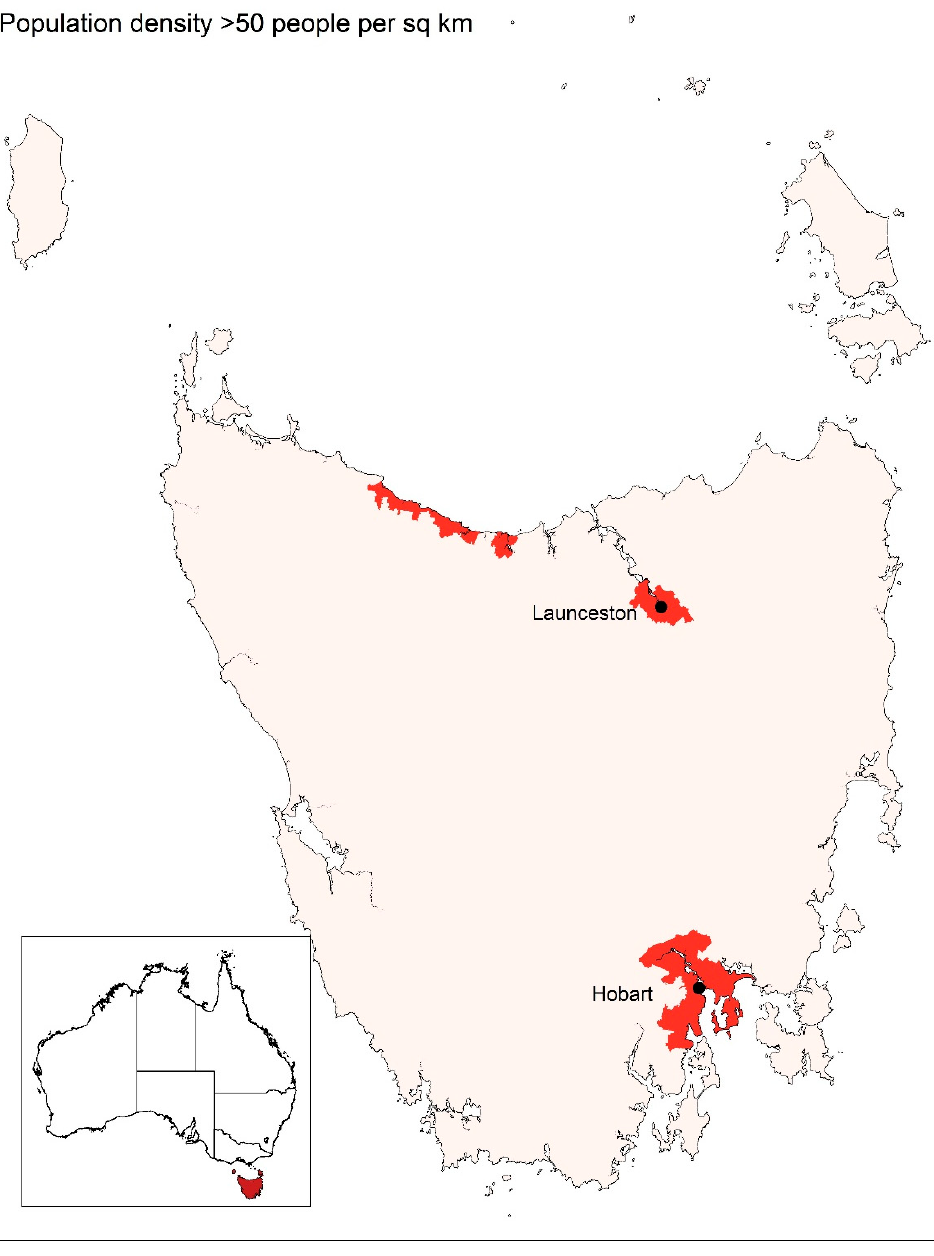
Figure 1. Locations in Tasmania where population density > 50 persons per km 2 [26], inset showing location of Tasmania within Australia.